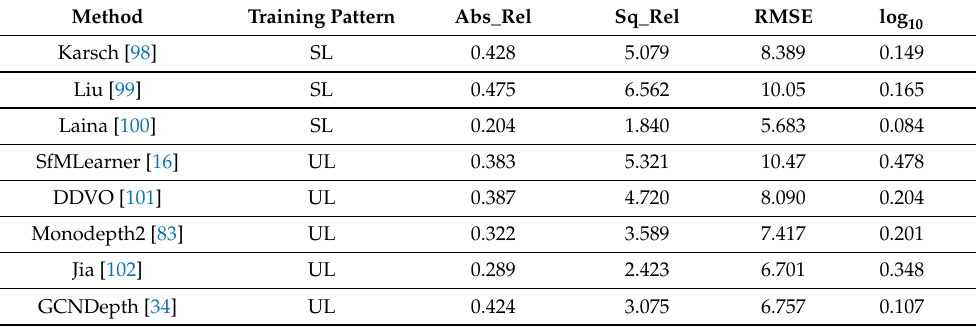
Table 4. Comprehensive information about the quantitative results of the DL algorithms investigated on the Make3D dataset.